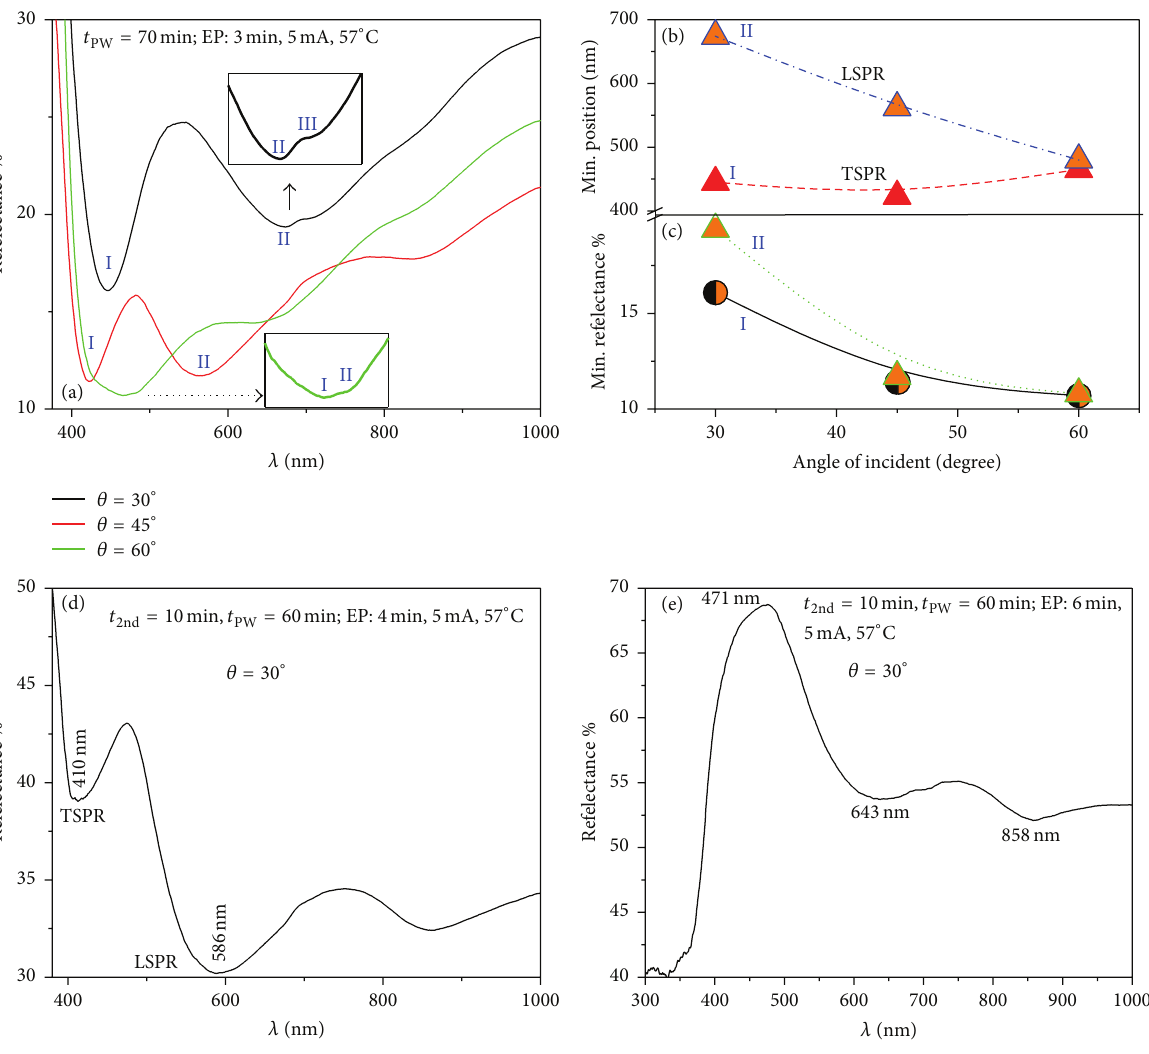
Figure 4: Reflectance spectra of (a) PAA membrane pore widened for 70min and electrodeposited with Au at 5mA and 57 ∘ C for 3 min and measured at different angles of incident and (b, c) their spectroscopic analysis and PAA membranes pore widened for 60min and electrodeposited at the same conditions for (d) 4min and (e)